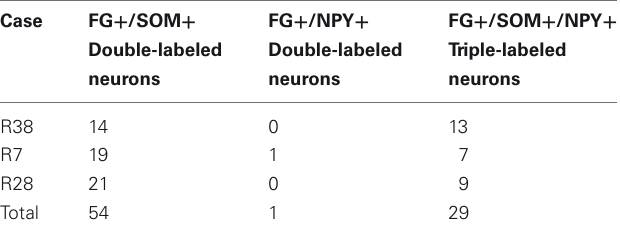
Table 2 | Cell counts of double and triple-labeled neurons in the amygdala in sections labeled for FG, SOM, and